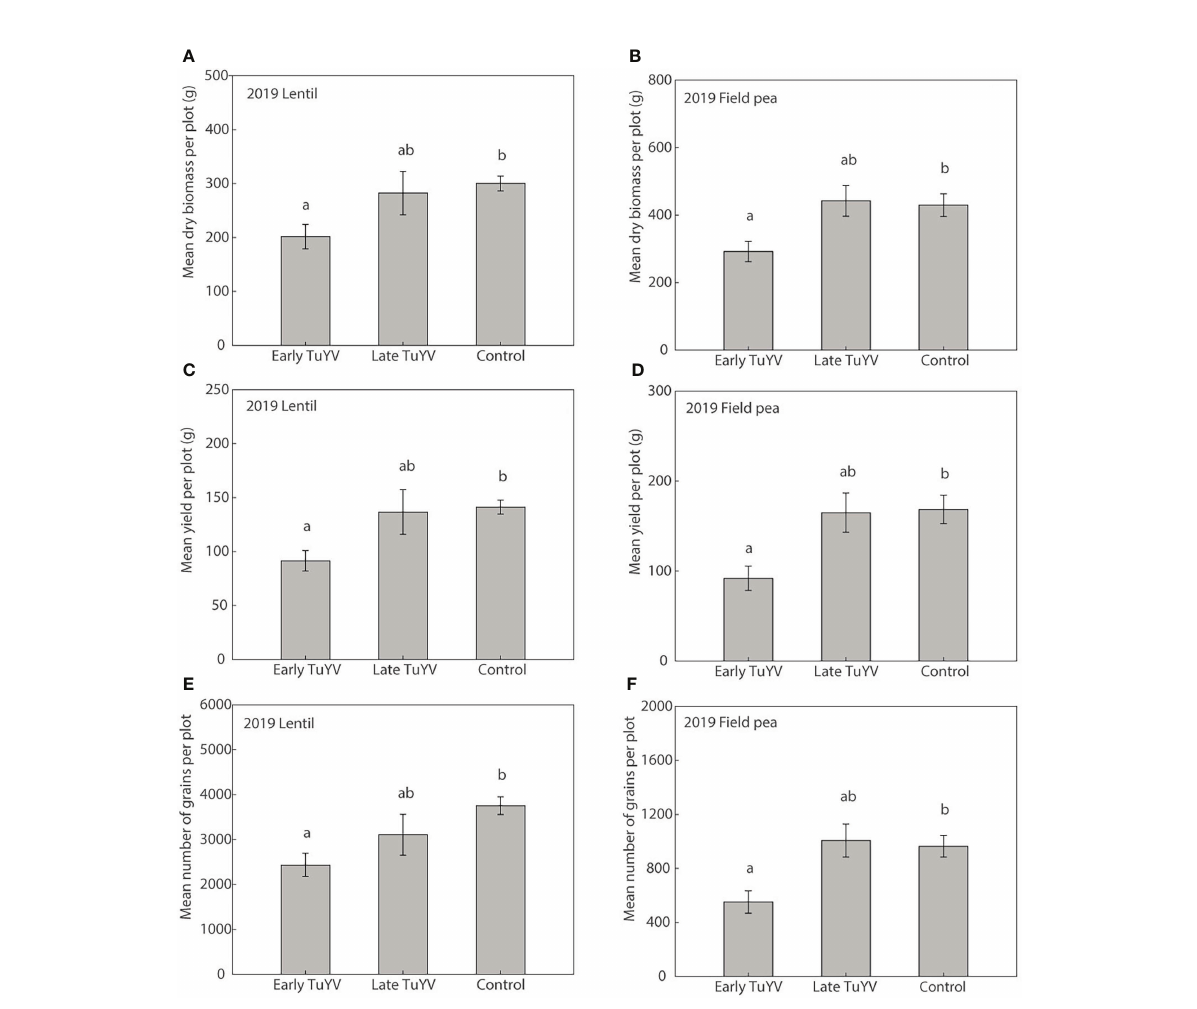
FIGURE 4 The effect of early and late turnip yellows virus (TuYV) infection on dry plant biomass (A, B) , grain yield (C, D) and number of grains (E, F) of lentil (left) and fi eld pea (right) in fi eld experiments (2019) in south-eastern Australia. Standard errors are represented by error bars; means with different letters are signi fi cantly different at p < 0.05 according to